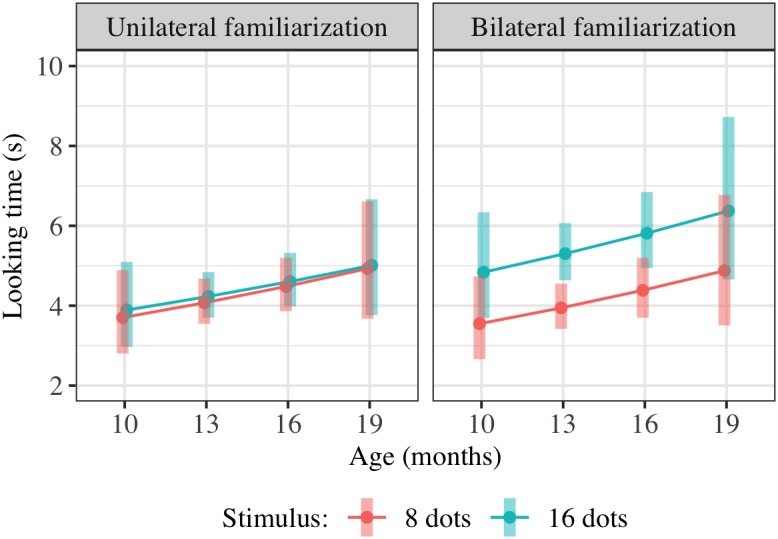
Interaction plot of estimated marginal means across combinations of familiarization condition and stimulus type over a set of reference ages spanning the tested age range, based on the linear mixed-effects model fitted using unilateral(-16) and bilateral familiarization data from Experiments 2, 3, and 4. Shaded error bars show 95% confidence intervals.